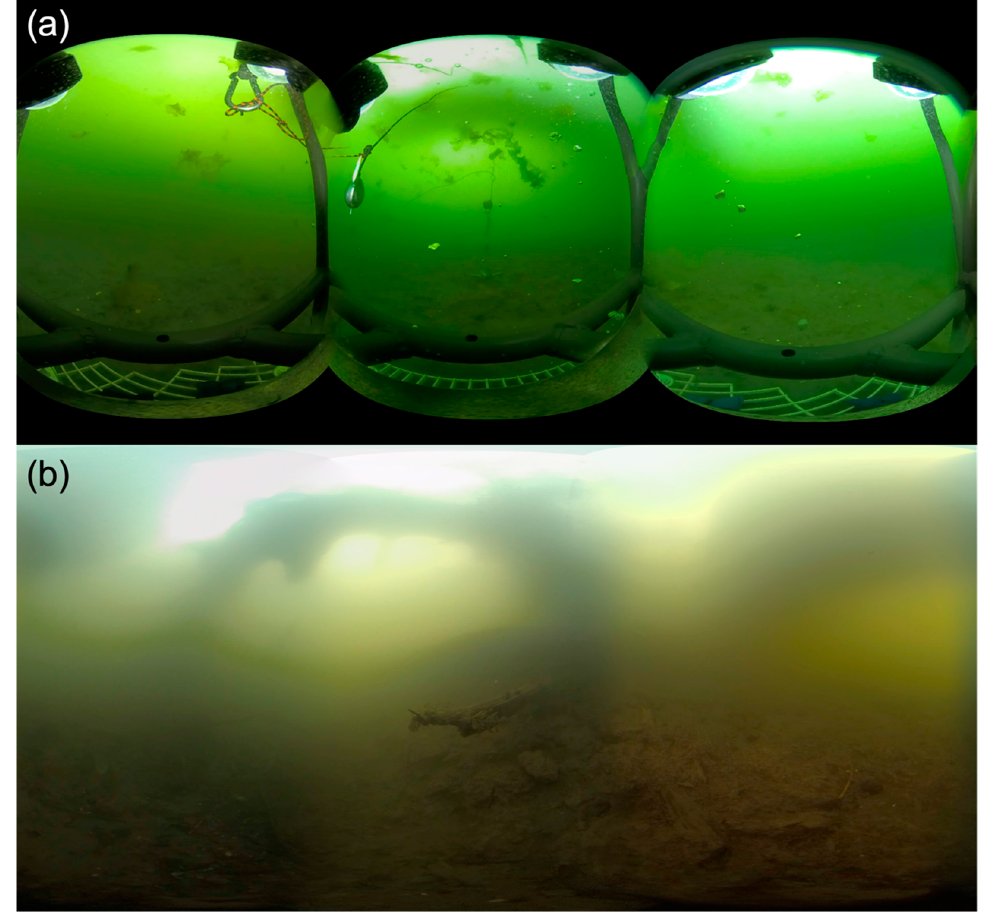
Figure 5. Screenshots from test deployments: ( a ) lander deployment in Sequim Bay, WA, on a day with a heavy phytoplankton bloom, with the live-stream camera centered in the foreground and the artificial target centered in the background; and ( b ) hand-held deployment in Seal Slough near Astoria, OR, in very turbid water, with a wood log target centered in the foreground.